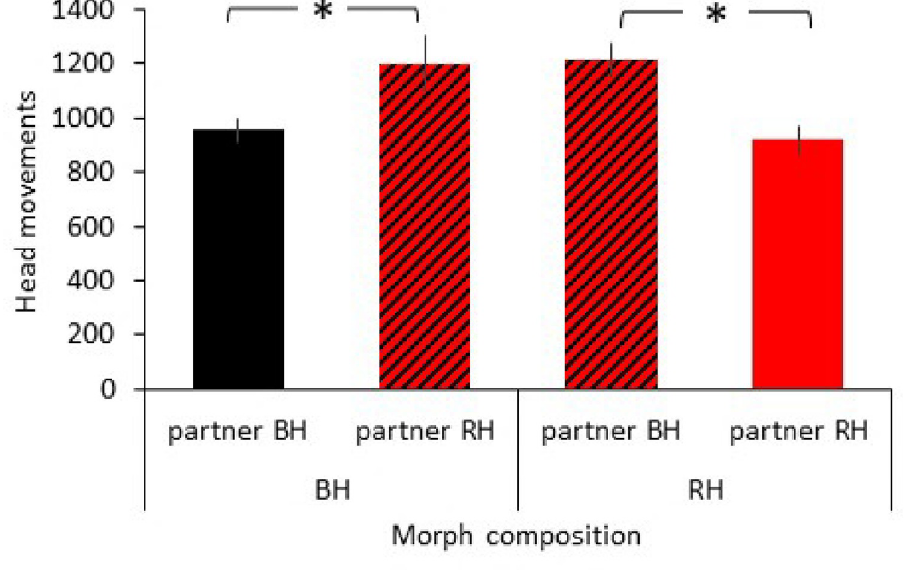
Fig 3. Effect of group composition on frequency of head movements. Mean and standard error of frequency of head movements per hour (n = 22) for black-headed (BH) and red-headed (RH) birds when in pure black-headed (black bar), red headed (red bars) or mixed head colour (hatched) morph pairings. � P < 0.05.